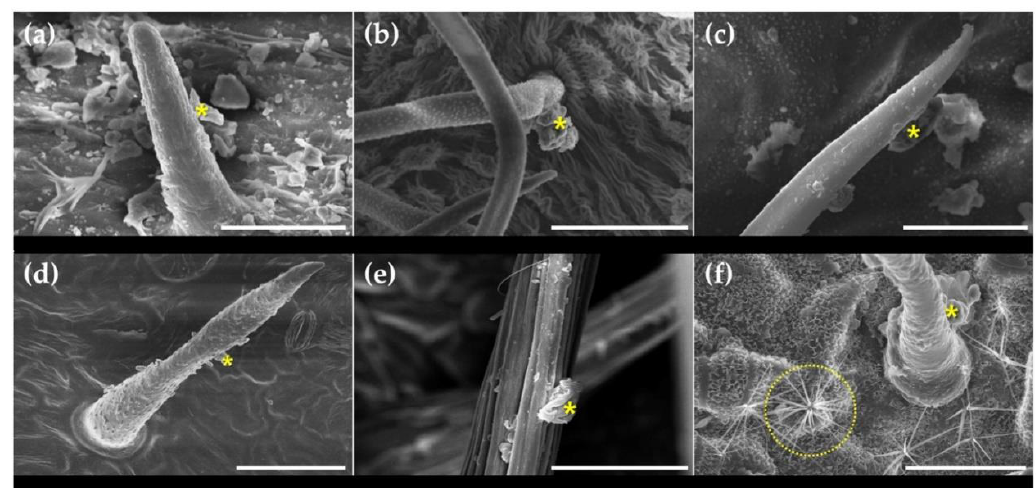
Table 3. Specific leaf micro-morphological characteristics (stomata and trichomes) on adaxial and abaxial leaf surfaces of ten species.